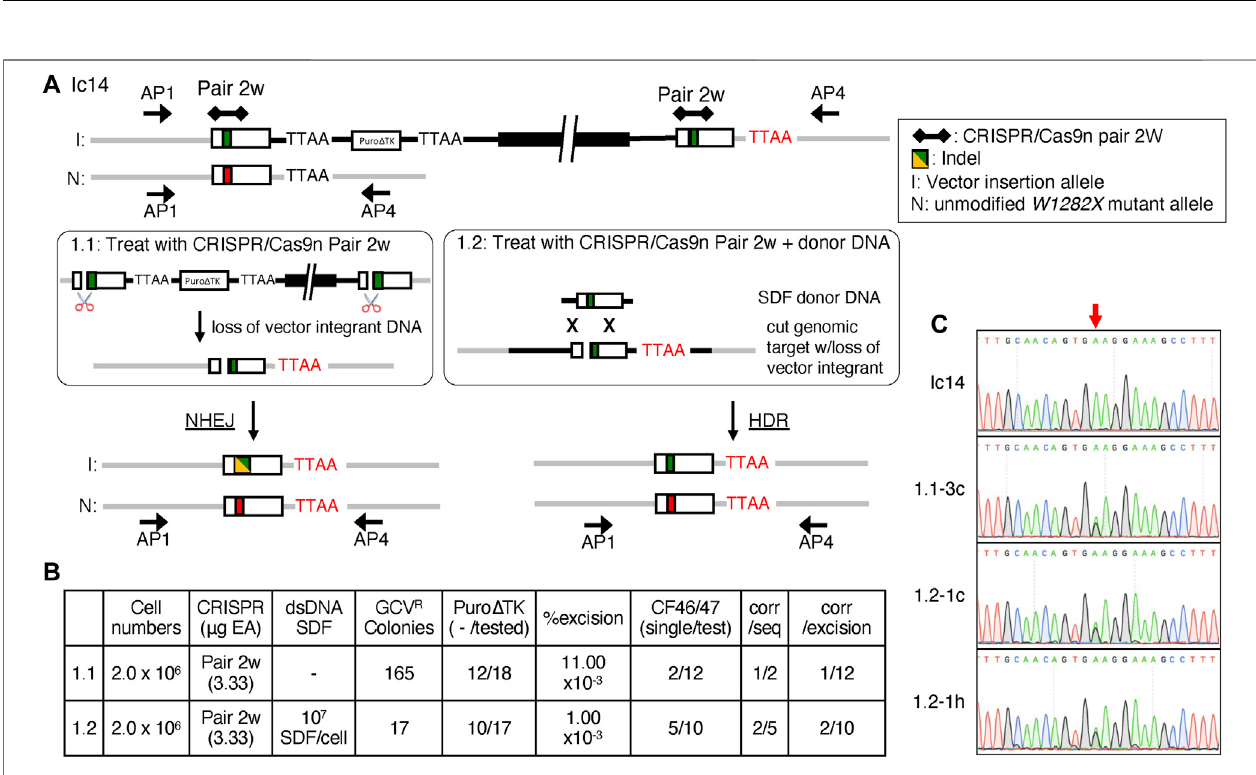
Frontiers in Genome Editing |